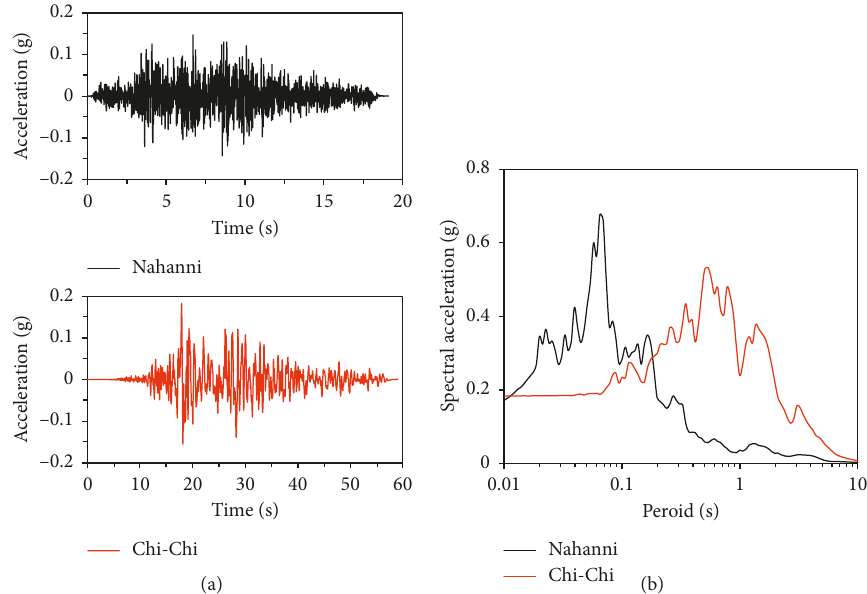
Figure 11: Additional earthquake ground motions. (a) Acceleration-time histories. (b) Acceleration response spectra.